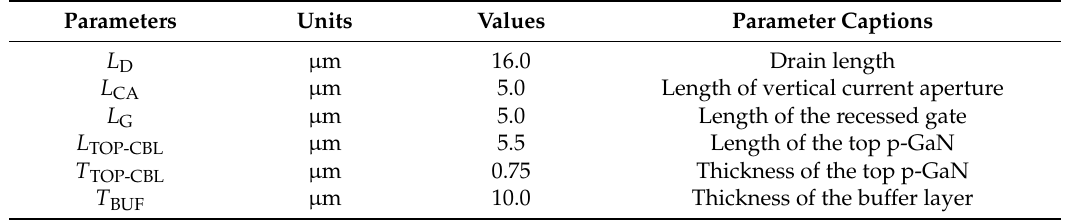
Figure 1. Cross-sectional schematic of the proposed GaN BCBL-VFET (back current blocking layer—vertical field-effect transistor). Table 1. Specifics of the proposed GaN BCBL-VFET.